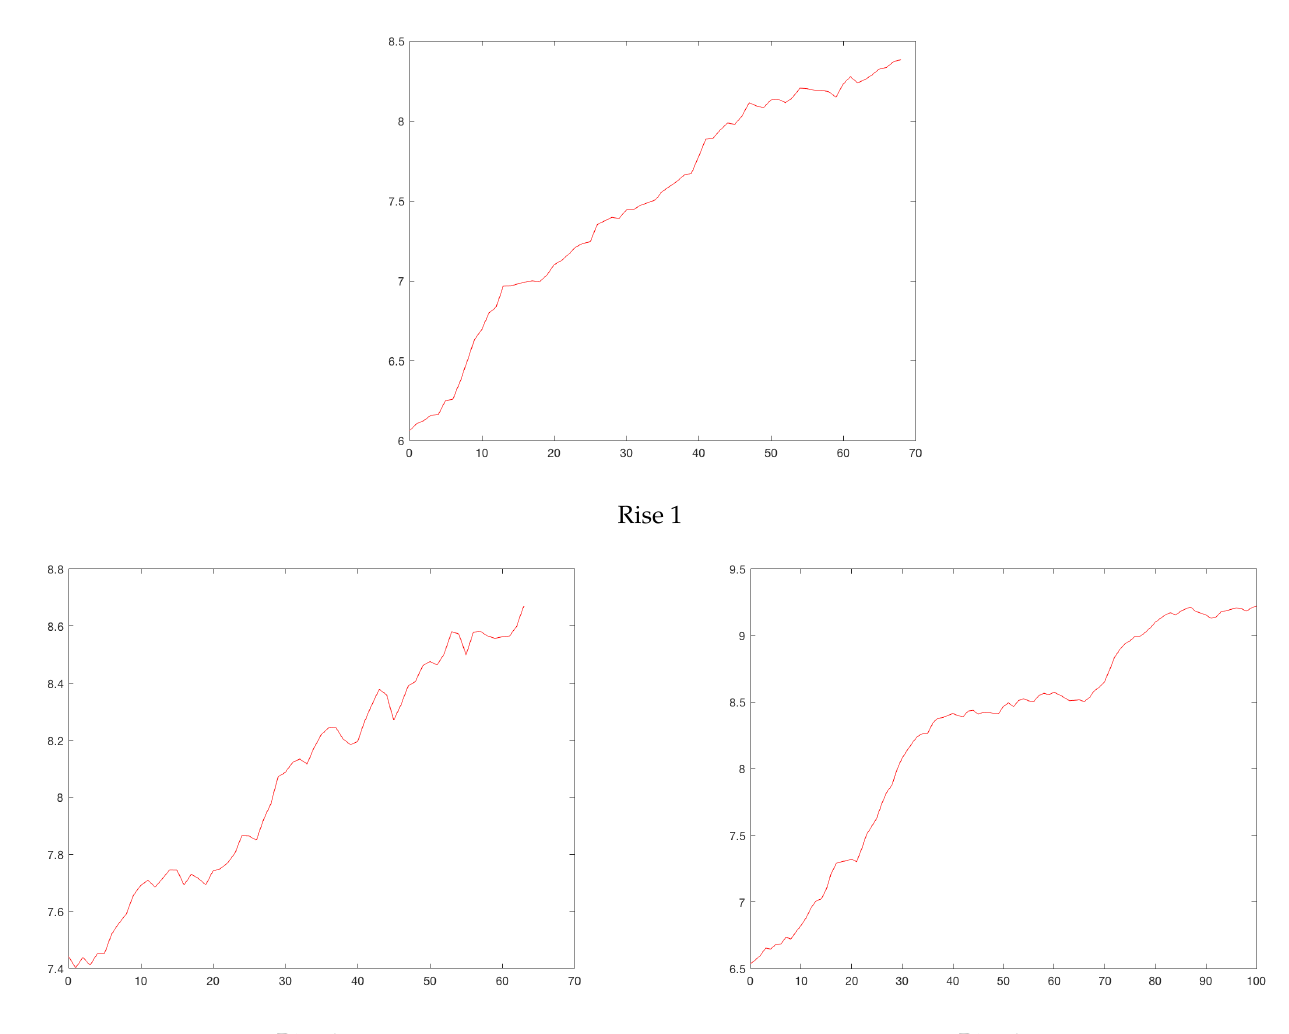
Figure A2. Bogota’s rises. Horizontal axis, days; vertical axis, logarithm of daily cases.